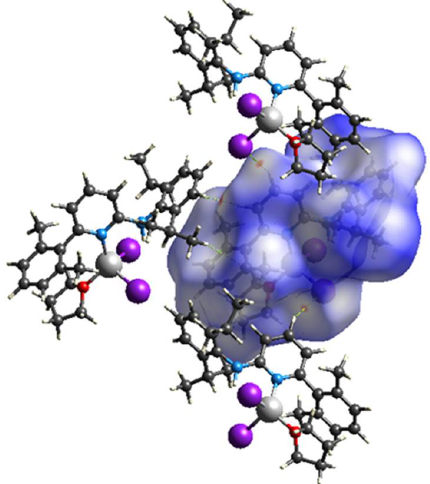
Figure 6. View of the three-dimensional Hirshfeld surface of 2 plotted over d norm in the range − 0.0888 to 1.3946.